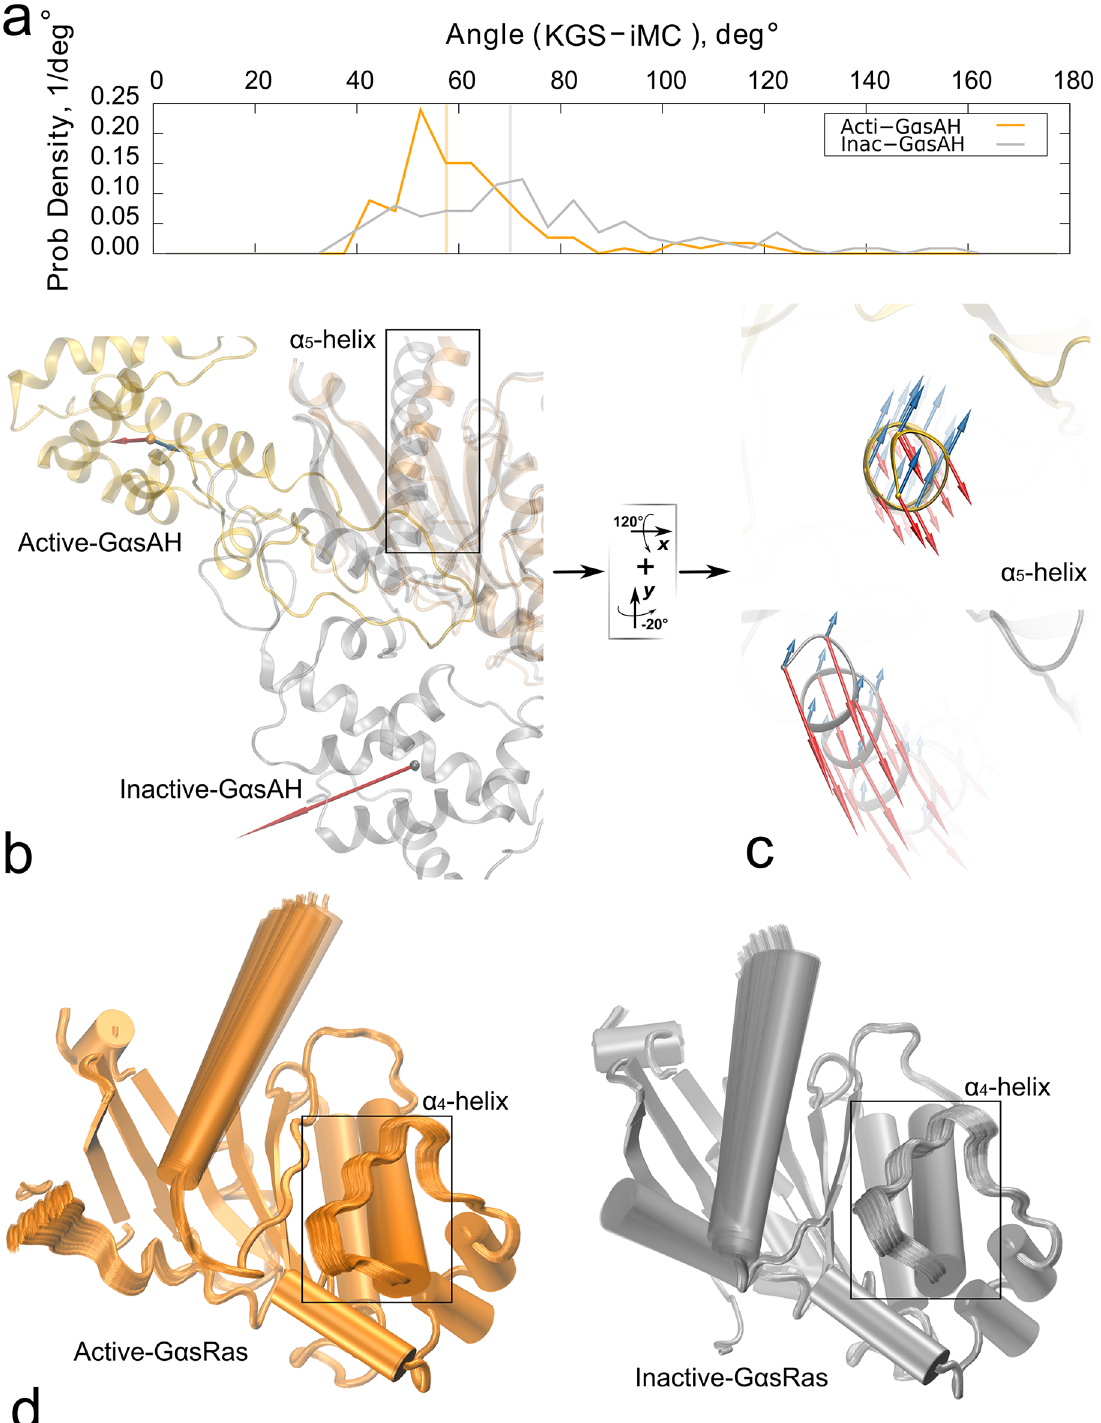
Fig 6. Direction of displacement of the AH-domain. a) Relative frequency of the angles between KGS and iMC average displacements for each C α of the AH-domain in the inactive (grey) and active states (orange/yellow). The average AH-domain displacement is shifted by 50 to 60 degrees for the states between the two methods. b) Differences in the directions of the mean displacement of the center of geometry of the G α AH-domain between the KGS (red) and iMC (blue) ensembles. c) Directionality of the CA displacements of the α 5 -helix in the KGS (red) and iMC (blue) ensembles in the active state (top) and inactive state (bottom). The motion in the KGS ensemble is directed from the inactive conformation of α 5 to the active conformation. d) Superimposed